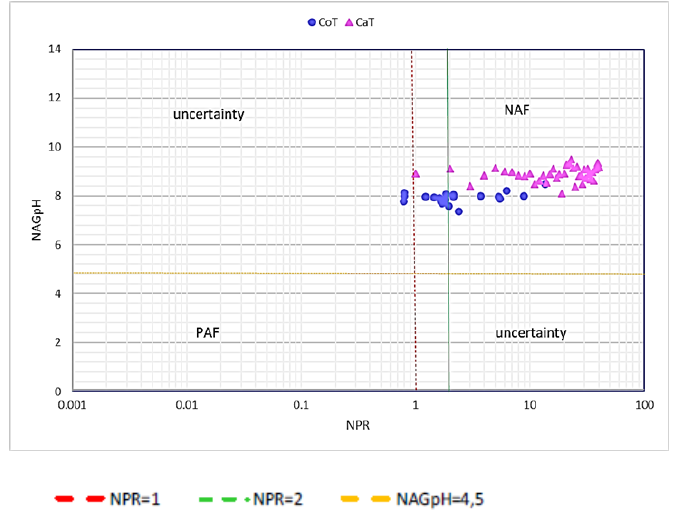
Figure 8. Relationship between the results of the MABA and Net Acid Generation (NAG) pH tests (NAF: region of non-acid-forming samples; PAF: region of potentially acid-forming samples).